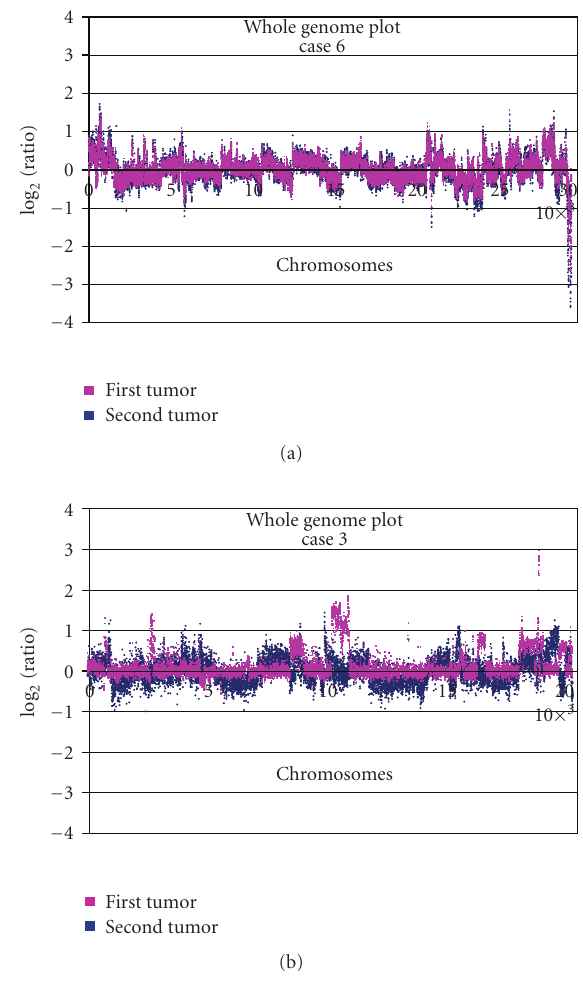
Figure 2: Superposition of whole genome plots from two di ff erent tumors from the same patient showing (a) similarities in gene copy number changes in two liposarcomas (case 6). (b) Di ff erences in gene copy number changes in two malignant fibrous histiocytomas (case